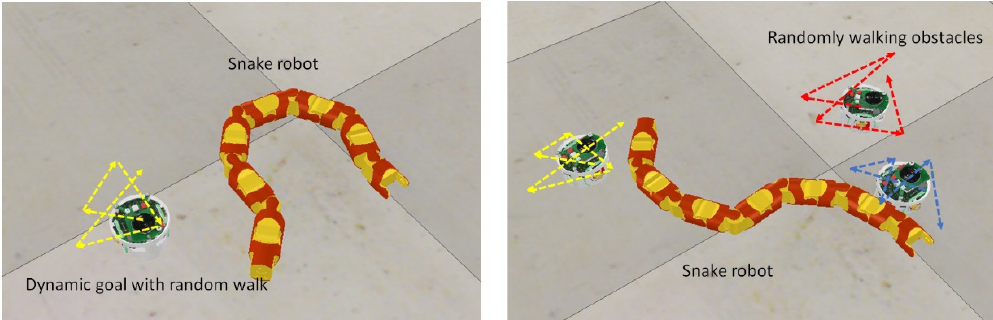
Figure 2. Training environment for goal-touch and obstacle-avoidance.